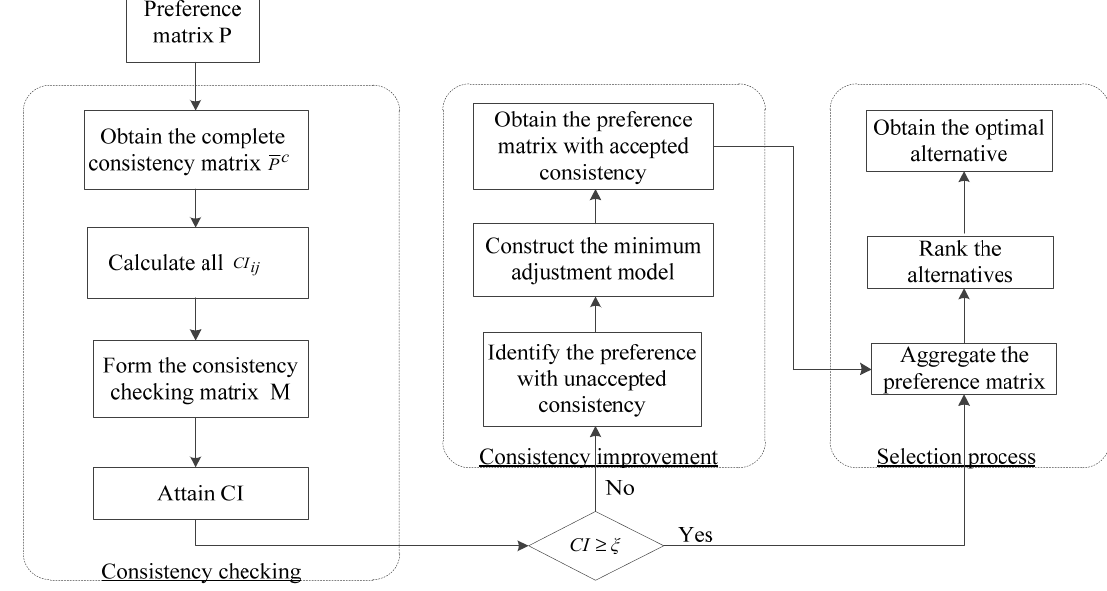
Figure 1. The flowchart of decision making.